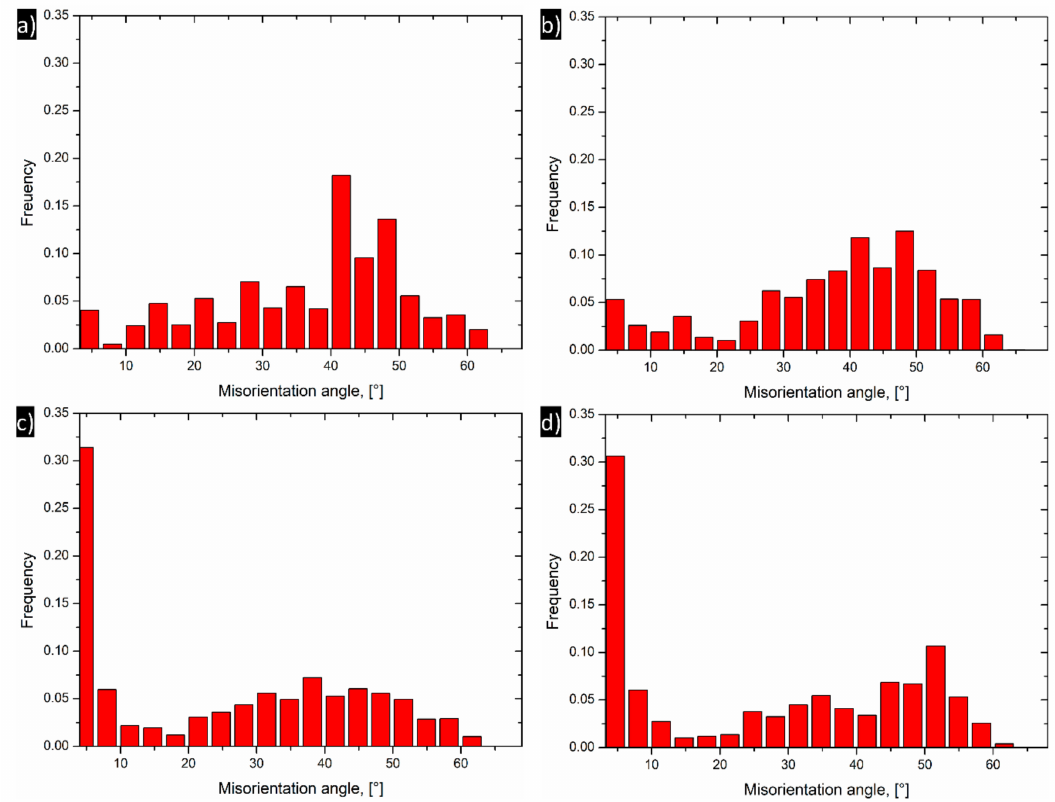
Figure 6. Misorientation distribution of the 5754 alloy samples ( a ) initial state, ( b ) one DRECE pass, ( c ) four DRECE passes, ( d ) six DRECE